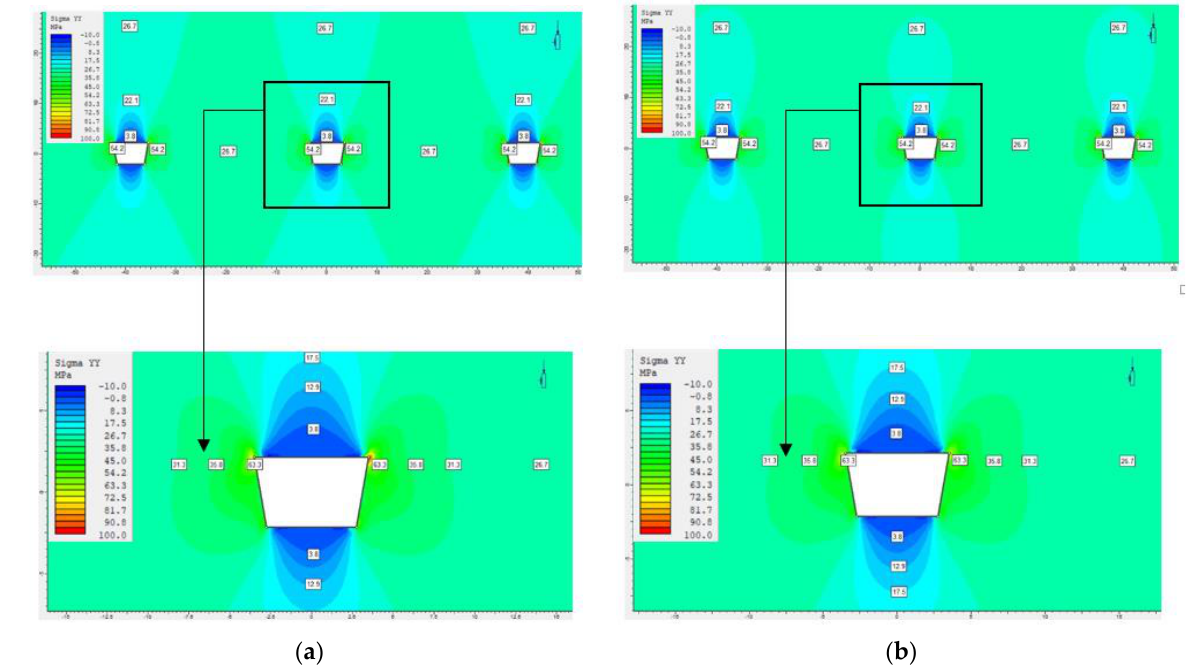
Figure 8. Close-up view of σ YY stresses values in the cross-section through entries drilled in: ( a ) sandstone, ( b ) dolomite.